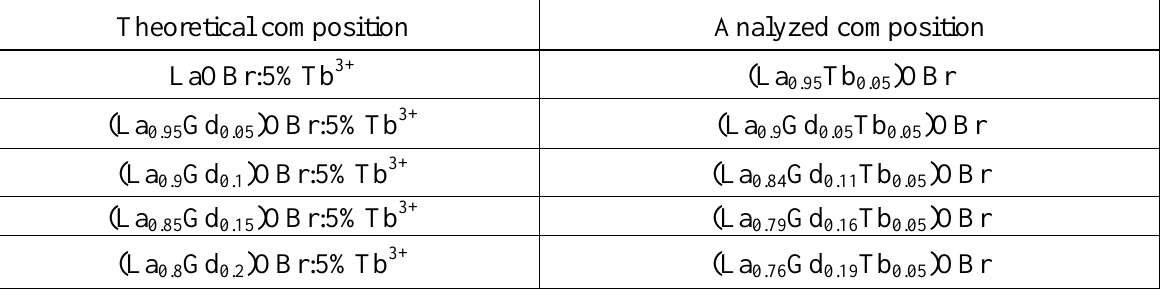
Table 1. Theoretical and analyzed compositions of the